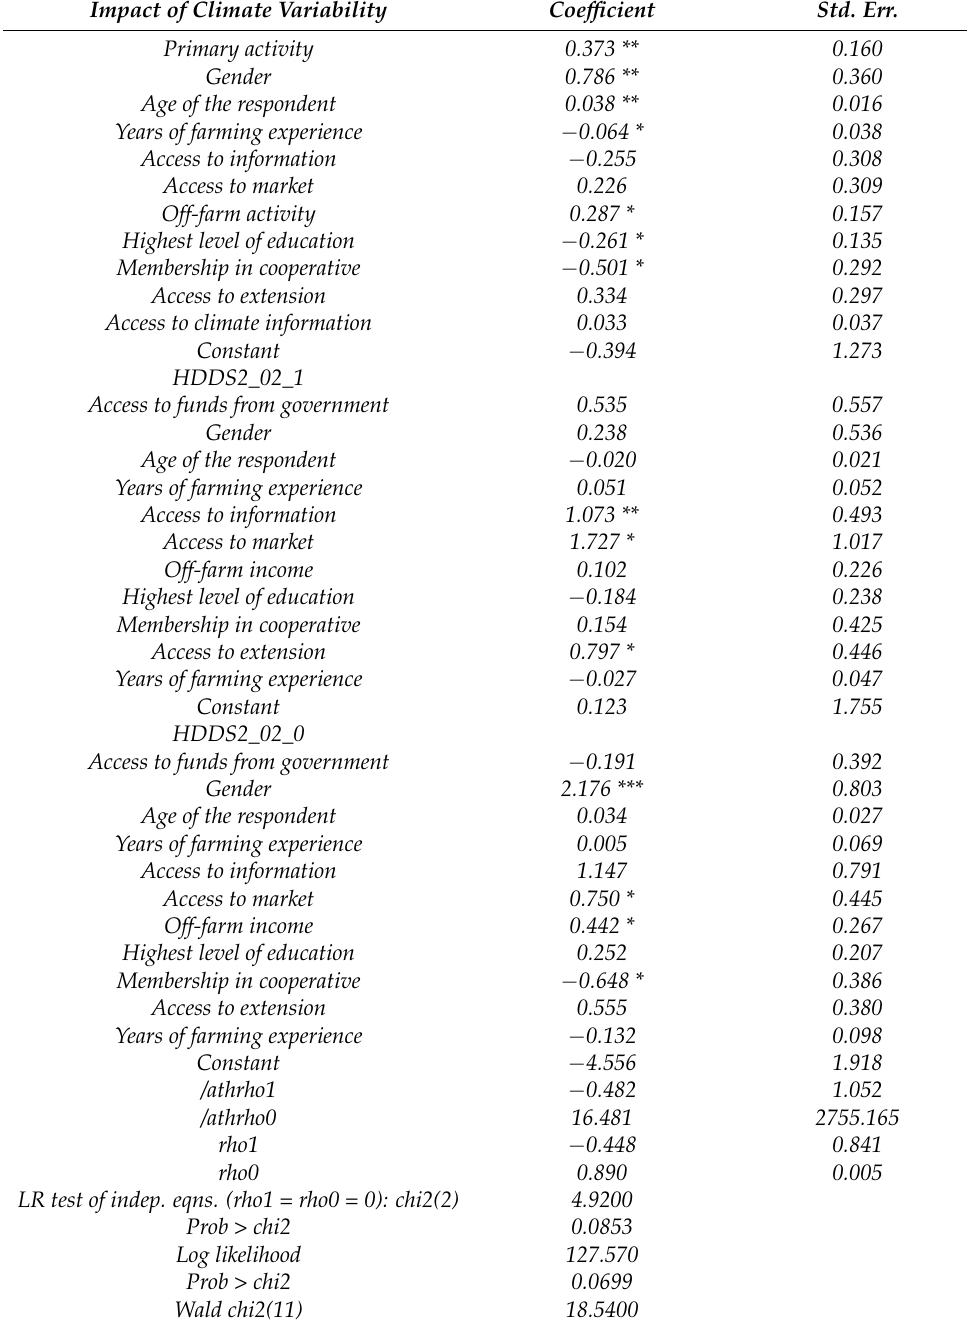
Table 4. Impact of climate change adaptation strategies on household food security—endogenous switching probit